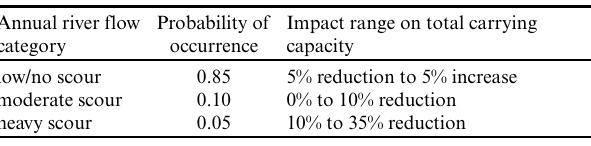
Table 1 . Parameters for stochastic flood regime scenarios used in the model to parameterize dynamic habitat availability and carrying